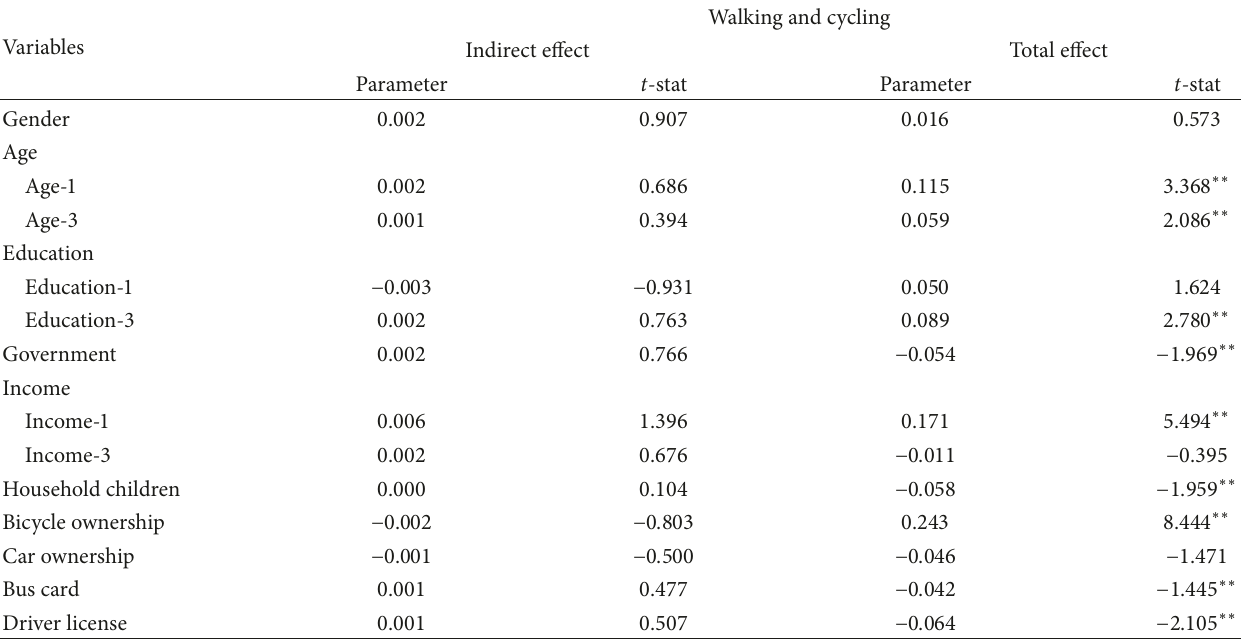
Table 6: Estimation results for the indirect and total effects of observed